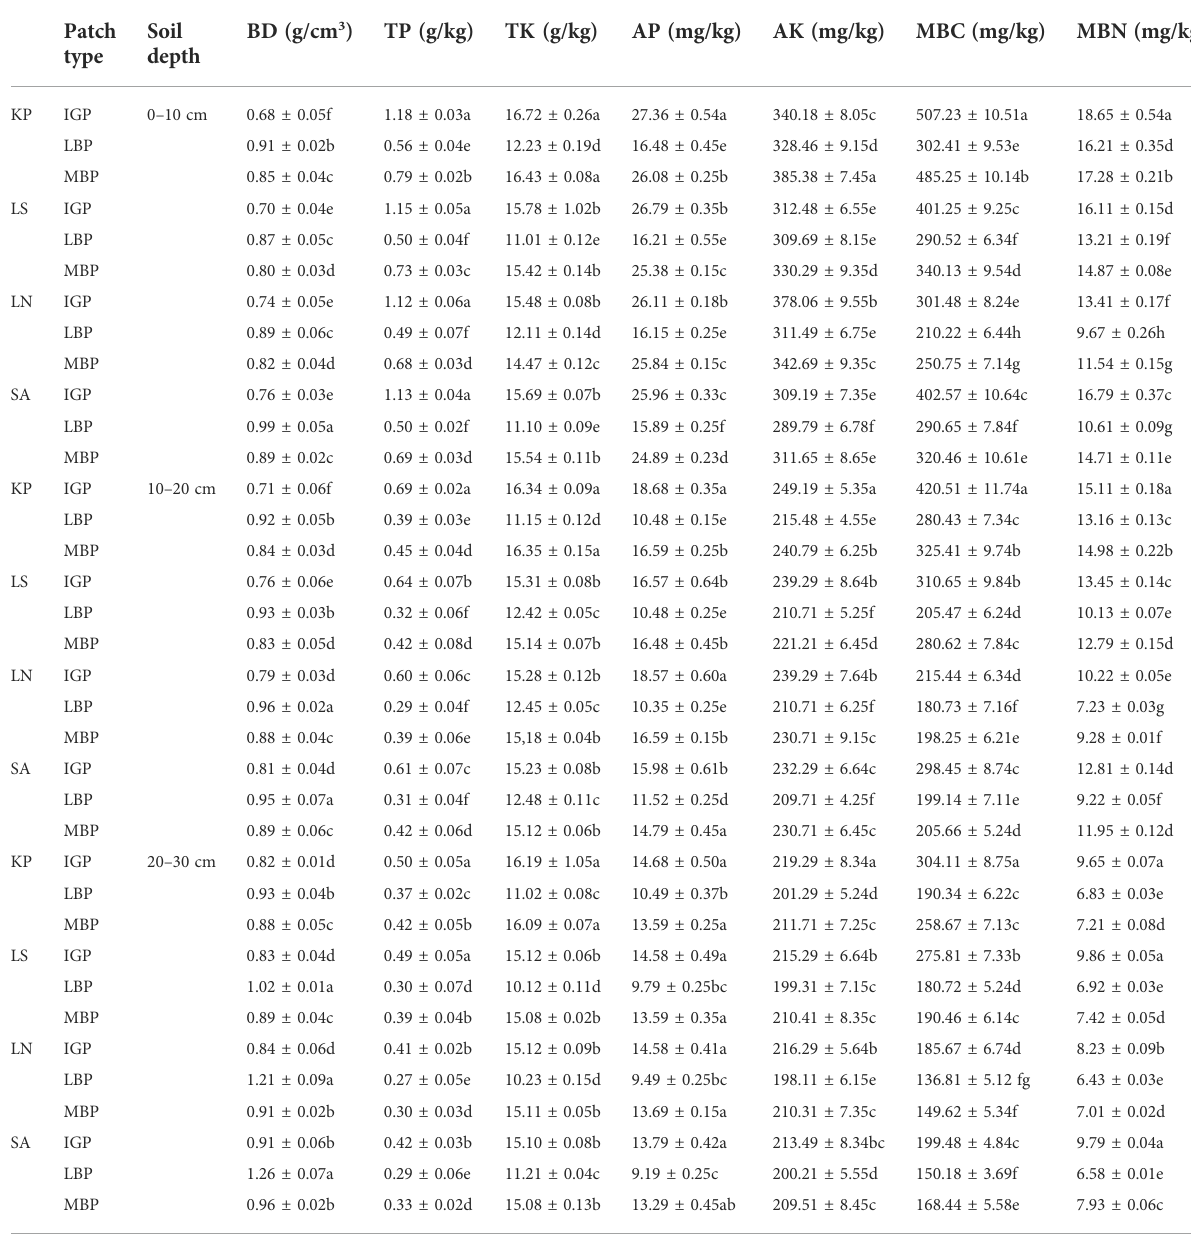
TABLE 2 Variation of soil physicochemical parameters within the selected patches. Patch